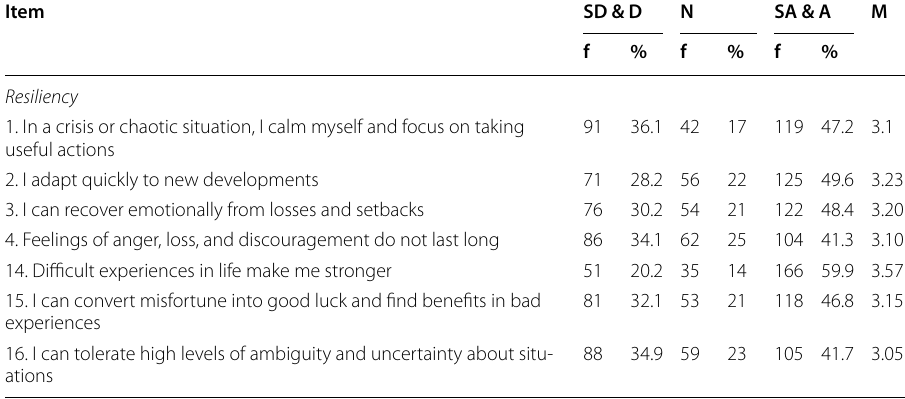
Table 7 Frequency, percentage, & mean score of responses to APPRSQ (resiliency) Item